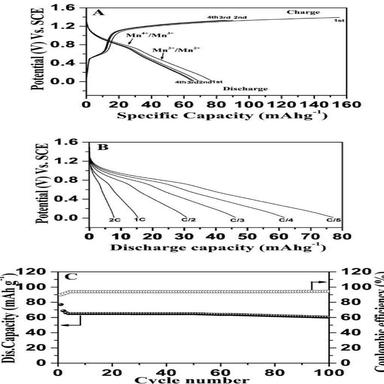
(A) Charge-discharge curves (B) Discharge curves at different C rates of Na3MnCO3PO4/NaTi2(PO4)3 cell in aqueous electrolyte (C) Capacity trend vs. number of cycles at C/5 rate and coloumbic efficiency vs. number of cycles.